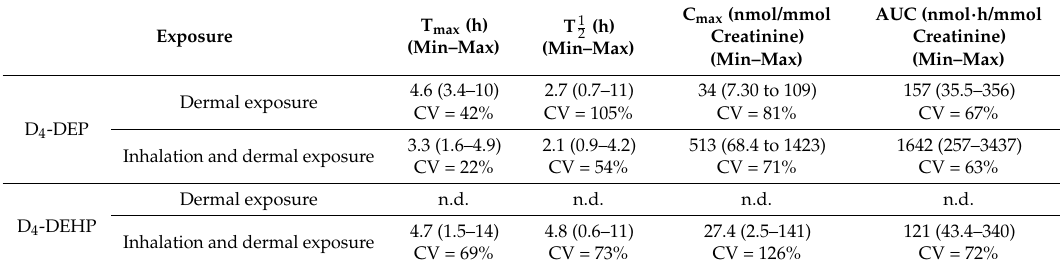
Table 1. Average urinary metabolites after three hours of inhalation and/or dermal exposure to D 4 -DEP and D 4 -DEHP, including the time points (T max ) of the maximum concentration (C max ) and the excretion half-life (T 1 ) of the excreted metabolites, and AUC (area under the excretion curve). Presented values 2 are averages, min and max values in brackets, and coefficient of coefficient of variation